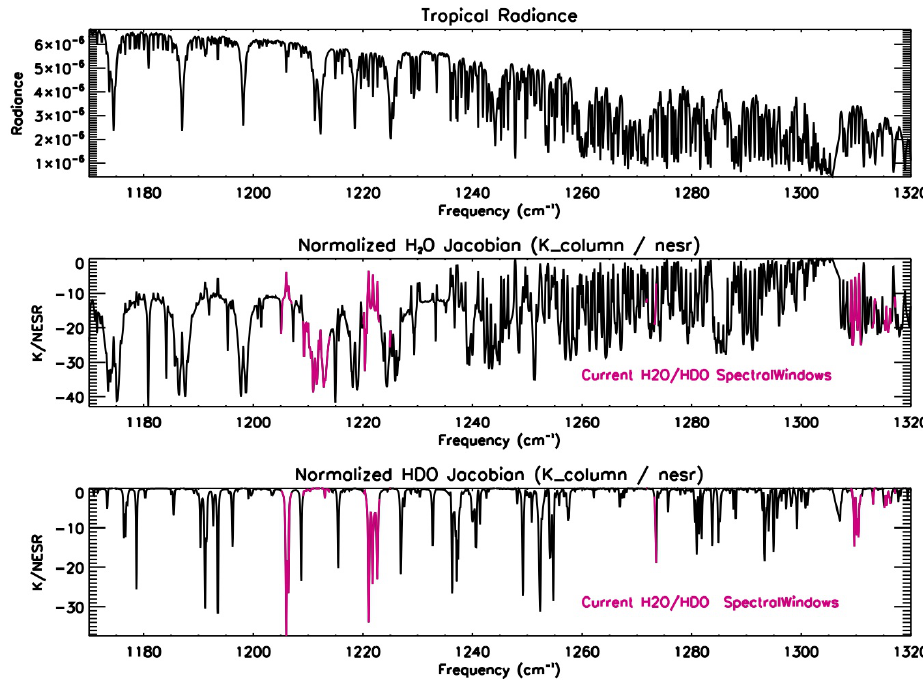
Fig. 1b. Same as in Fig. 1a but for H 2 O and